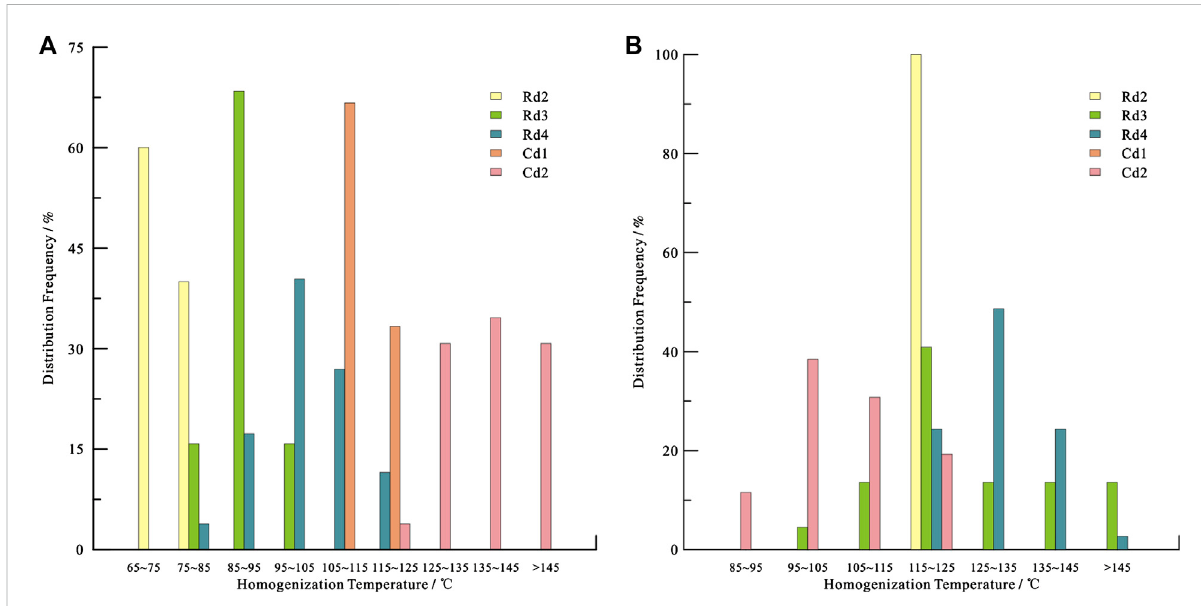
FIGURE 9 Histogram of the homogenization temperatures for fl uid inclusions in different dolomite phases. (A) Various dolomites without misty centers and clear rims. (B) Clear rim parts of dolomite samples with misty centers and clear rim